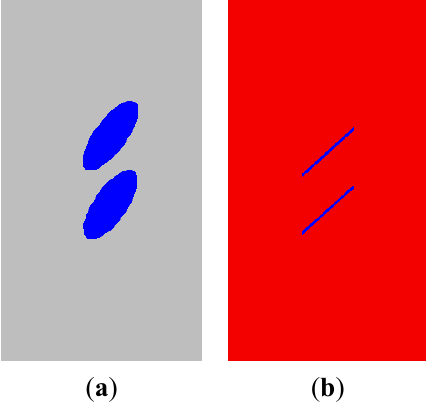
Figure 6. The three-dimensional model. ( a ) A side view; ( b ) A front view.